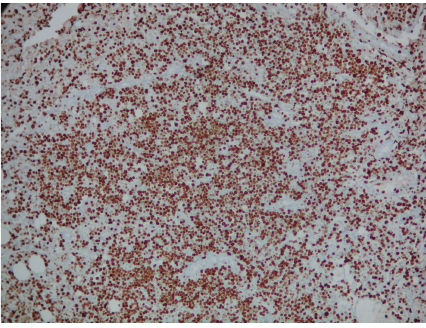
Figure 1: Hematoxylin and eosin stain showing salivary gland and lymphoid components. Small lymphocytes on the left and large lymphocytes on the right.